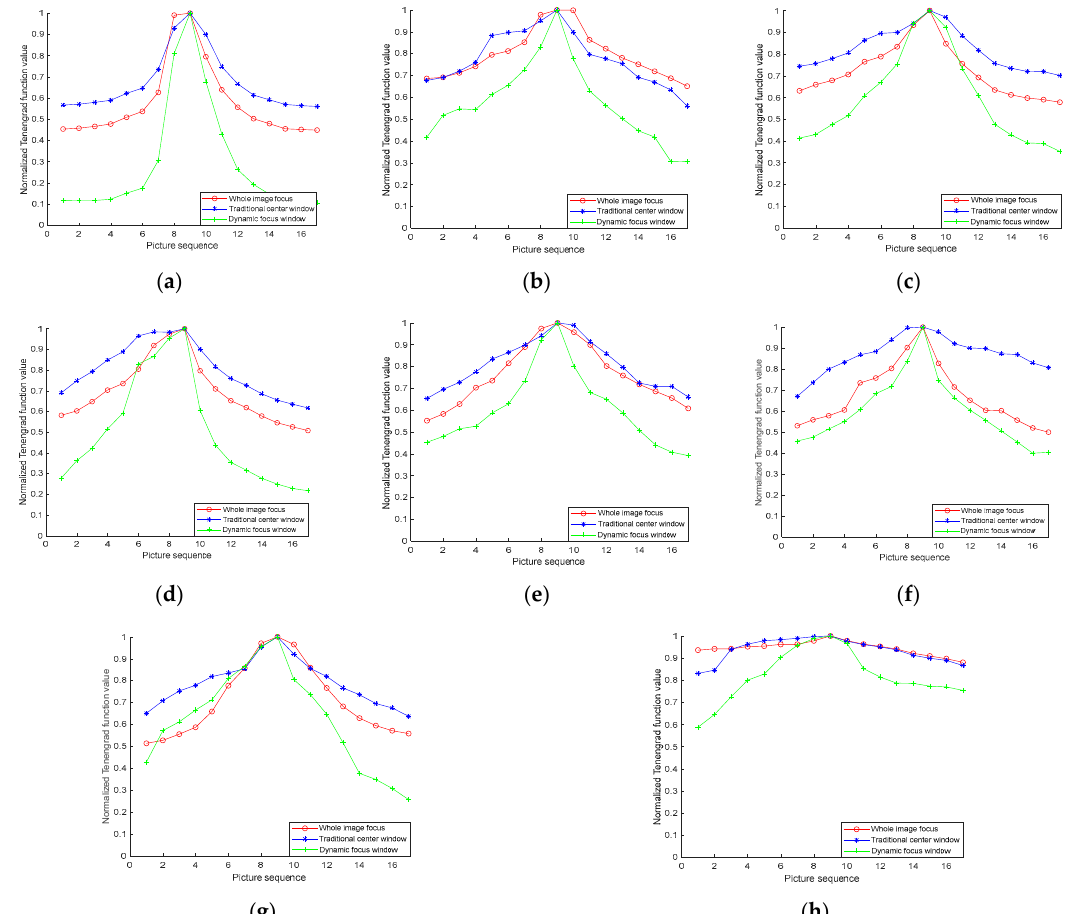
Figure 6. Comparison of three auto-focusing window selection methods: WIF (whole-image focus), TCFW (traditional center window), and ES-DAWF (even sampling–dynamic adaptive focusing window selection).